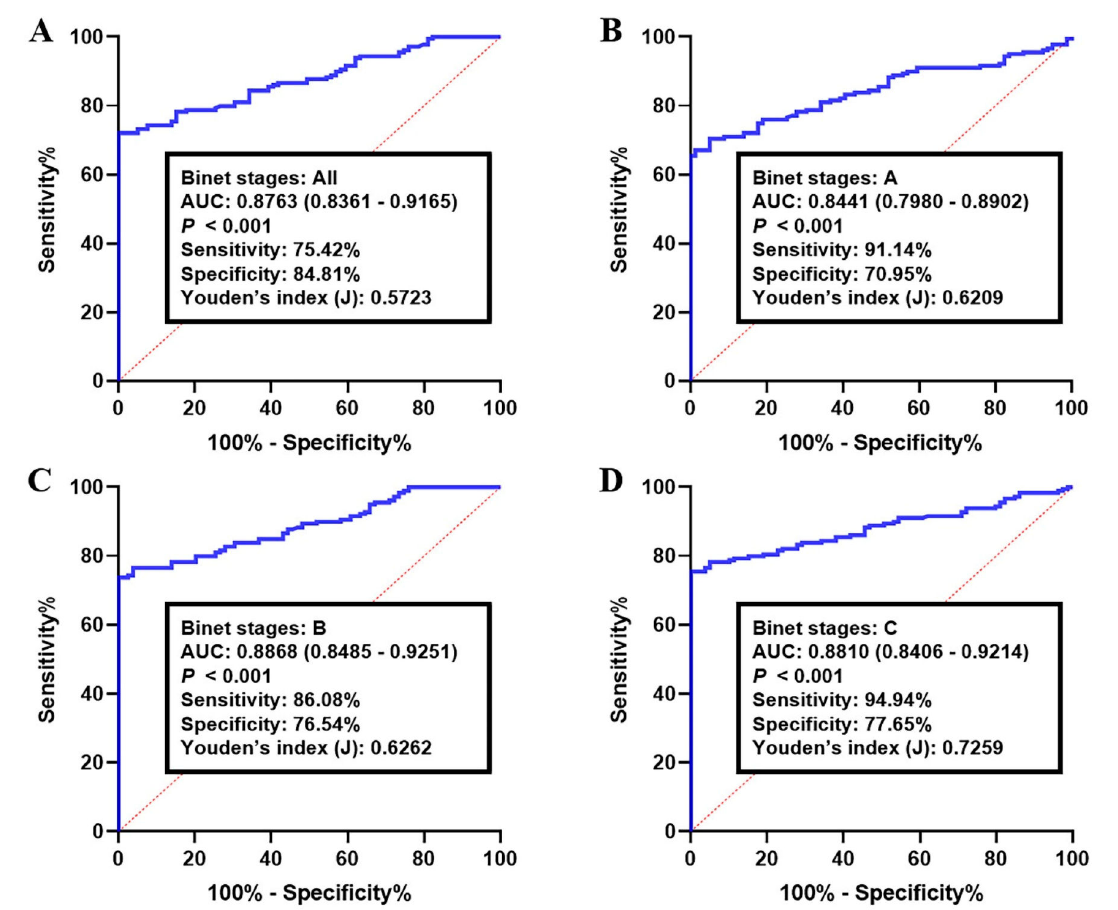
Figure 2. Receiver operating characteristics (ROC) curve analysis of the log it model with the cir- cKAT6A/circLNPEP/circMDM2/circMYH9 panel in the training set. The study group consisted of 100 CLLs and healthy B-lymphocytes. Using the optimal cutoff value of 0.7262, the diagnostic per- formance of the circRNA panel for discriminating CLLs with ( A ) all Binet stages, ( B ) Binet stage A, ( C ) Binet stage B, and ( D ) Binet stage C from healthy samples were examined. Log it (p) of the model was 0.7262 + 0.7690 × CircKAT6A + 0.1786 × CircLNPEP − 0.2246 × CircMDM2 + 0.9938 ×